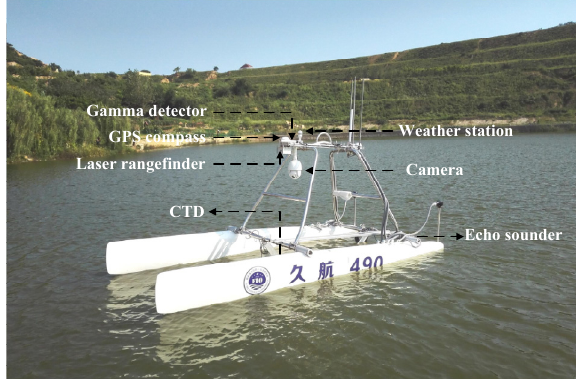
Figure 3. The ‘Jiu Hang 490’ USV and